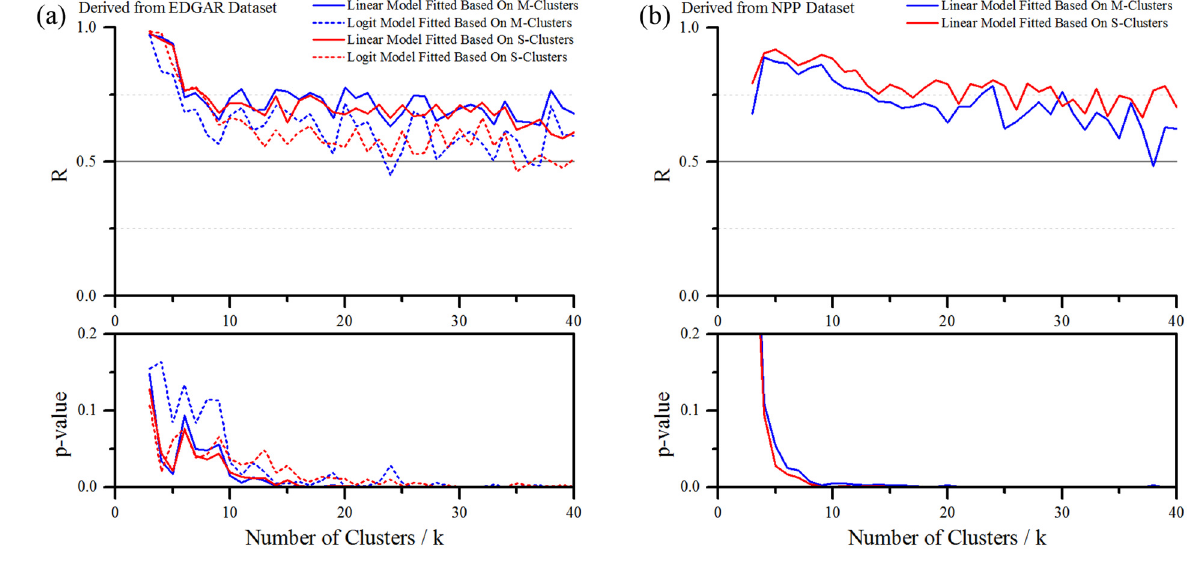
average and CO 2 emissions based 2 amplitude and NPP based on the 2